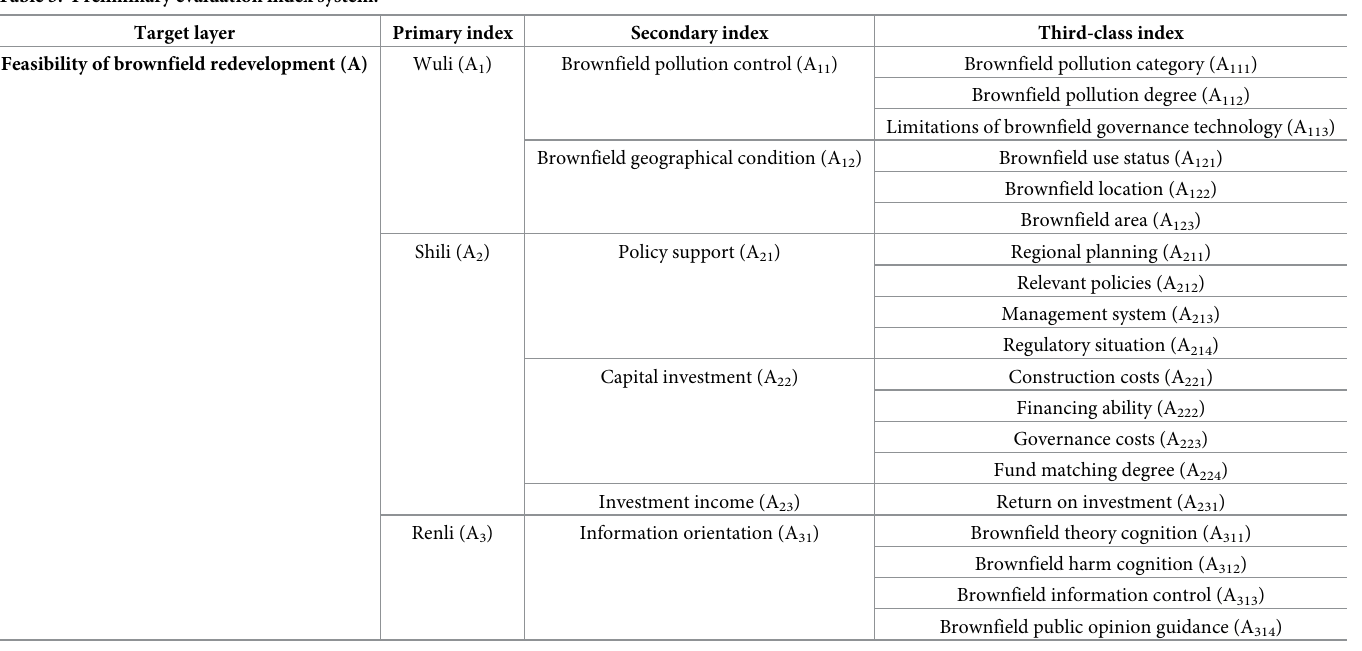
Table 5. Preliminary evaluation index system.